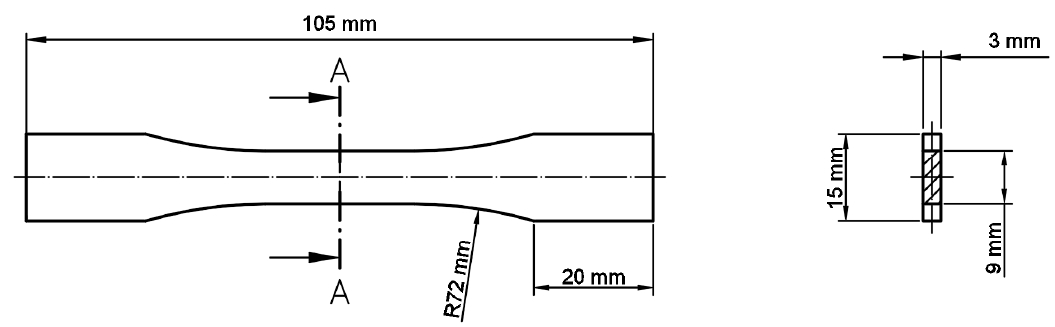
Figure 2. Dimensions of the ASTM E466 96 standard tensile test dog-bone sample.